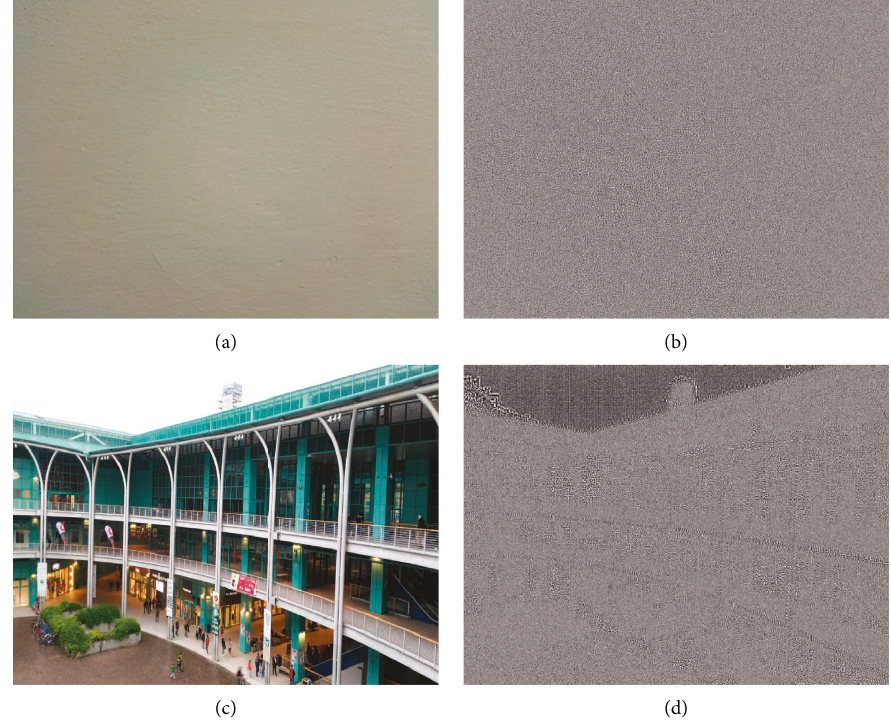
Figure 1: (a) Flat digital image (4160 × 3120) of the digital camera in a smartphone Huawei P8; (b) equivalent digital image of the PRNU extracted from (a); (c) natural digital image (3264 × 1836) of the digital camera in a smartphone Asus Zenfone 2; (d) equivalent digital image of the PRNU extracted from